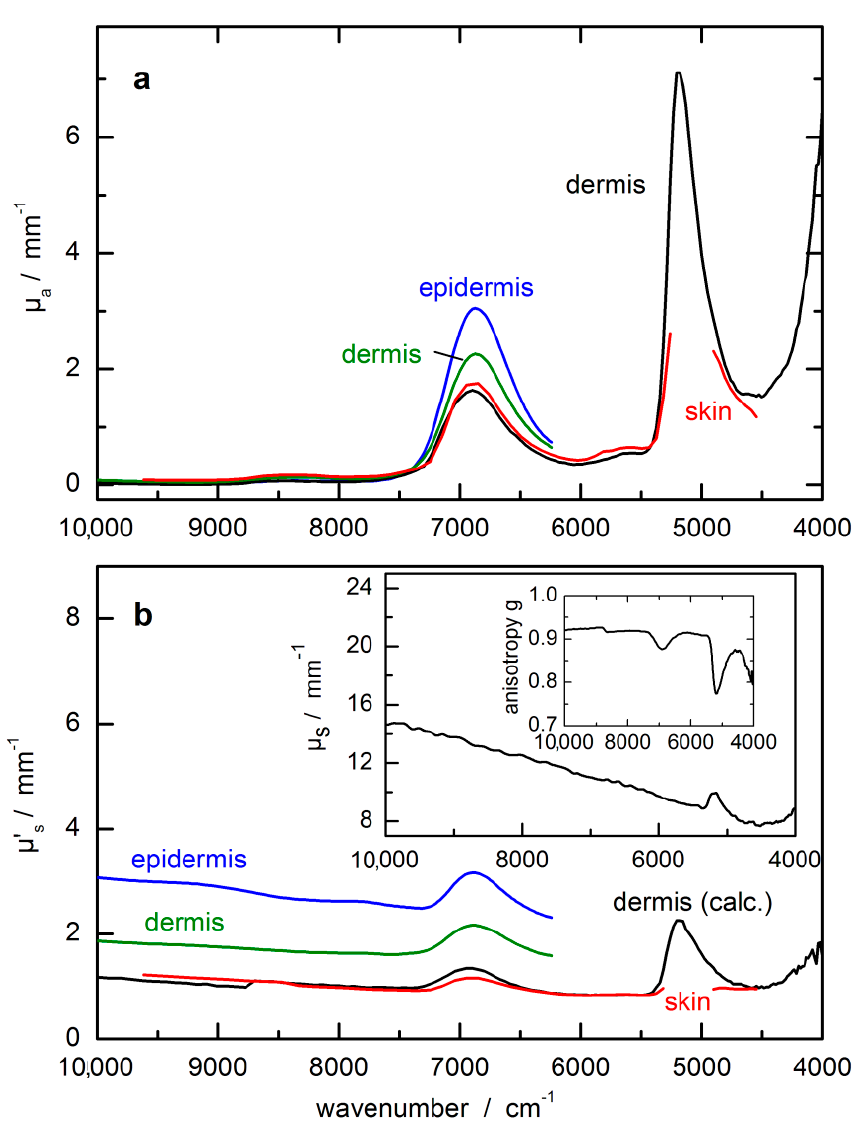
Figure 4. Optical constants of skin, dermis and epidermis from NIR-spectral measurements. ( a ) μ a ( ῦ ) = absorption coefficient; ( b ) μ ’ s ( ῦ ) = reduced scattering coefficient with μ ’ s ( ῦ ) = (1 - g( ῦ )) μ s ( ῦ ); this parameter includes the scattering coefficient μ s ( ῦ ) and the anisotropy factor g( ῦ ); optical constants were compiled from refs. [44–46]; obvious differences in the scattering coefficients within the near-infrared (NIR)-spectral range must be noted.